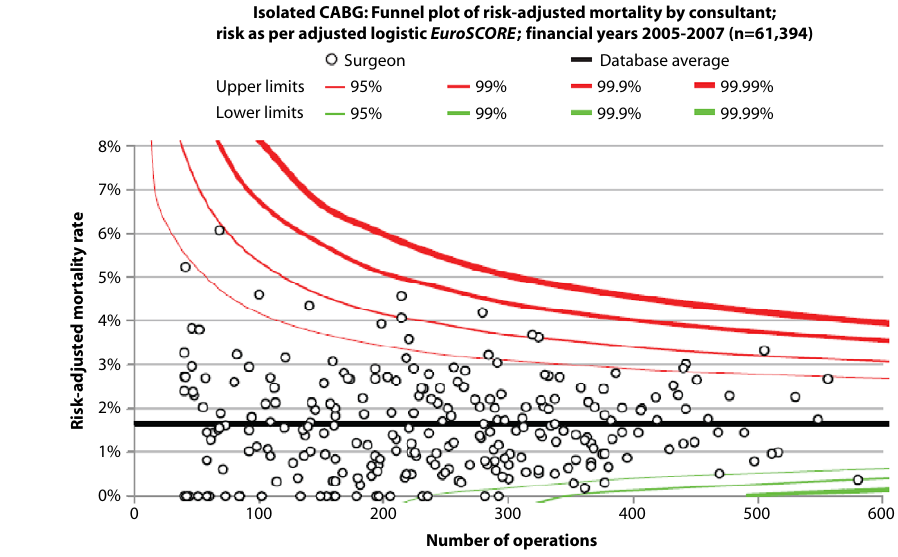
Figure. 3 Funnel plot individual surgeons mortality for first time isolated CABG in the UK. Acknowledgement Bridgewater B, Kinsman R, Walton P and Keogh B. Demonstrating quality: The sixth National Adult